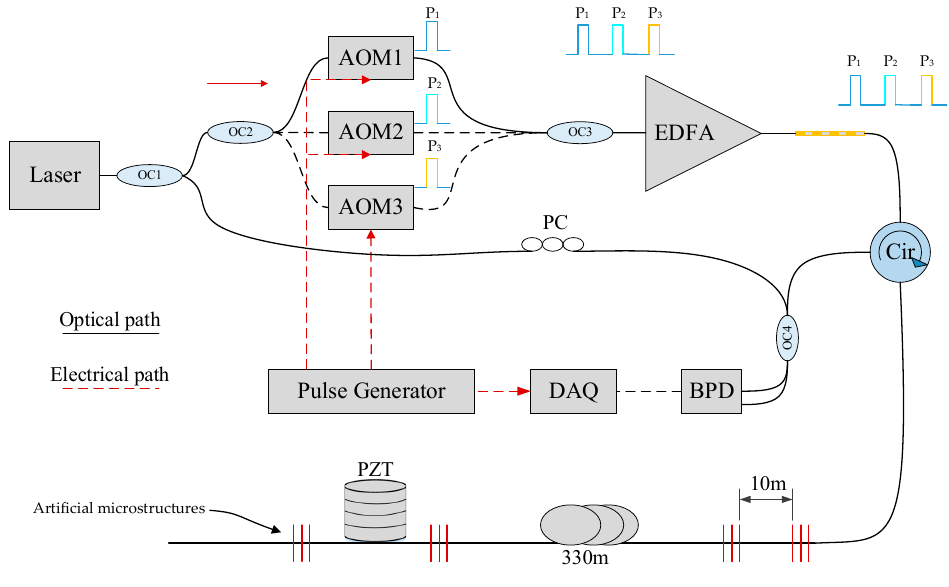
Φ -OTDR sensing system